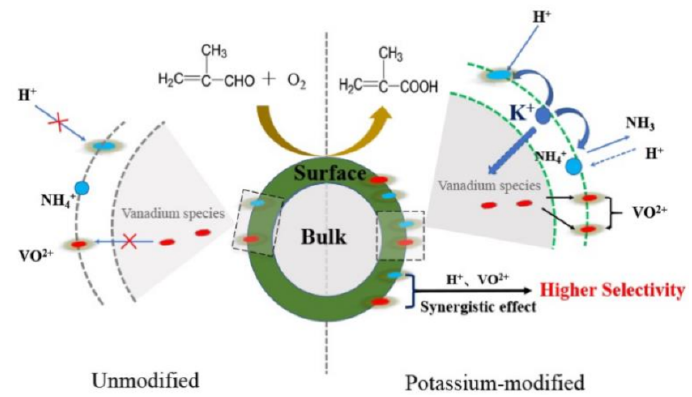
Figure 11. Conceptual diagram of the effects of K ions on P-Mo-V